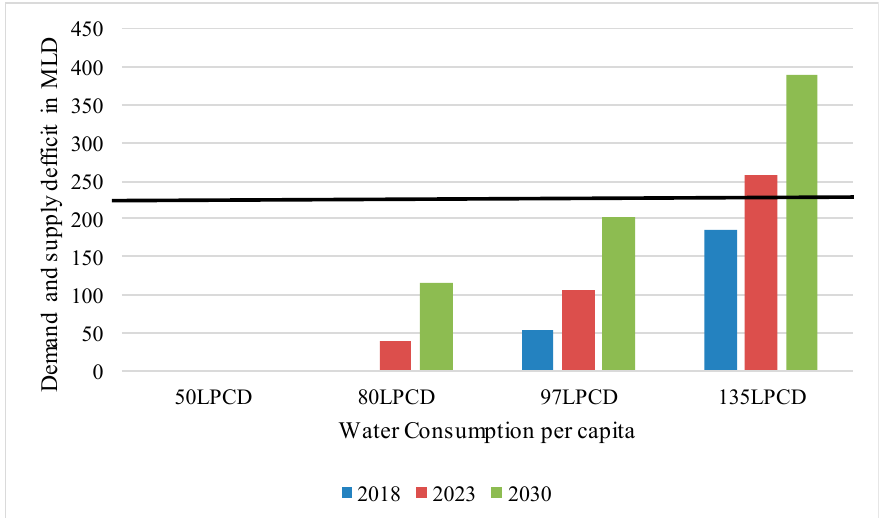
Figure 2. Demand and supply deficit of KUKL water for various water consumption scenarios. The black straight line represents the water supply-demand deficit Pre-MWSP for KUKL.